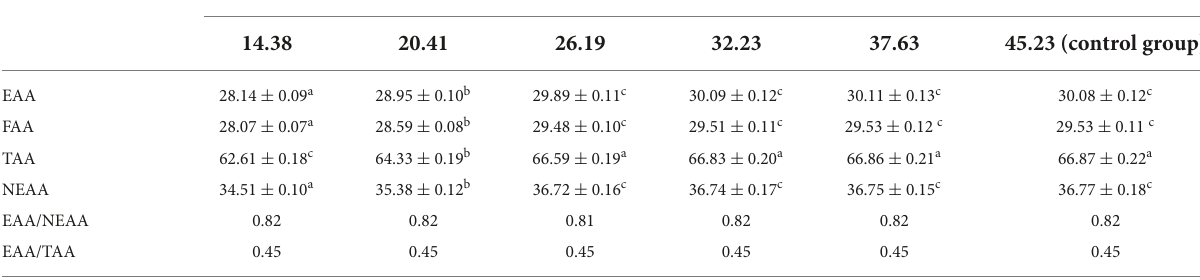
TABLE 2 Impact of a gradient of dietary protein levels on the muscle amino acid profile of P. sinensis , a softshell turtle (means ± SD, n = 15). Amino acids (%)